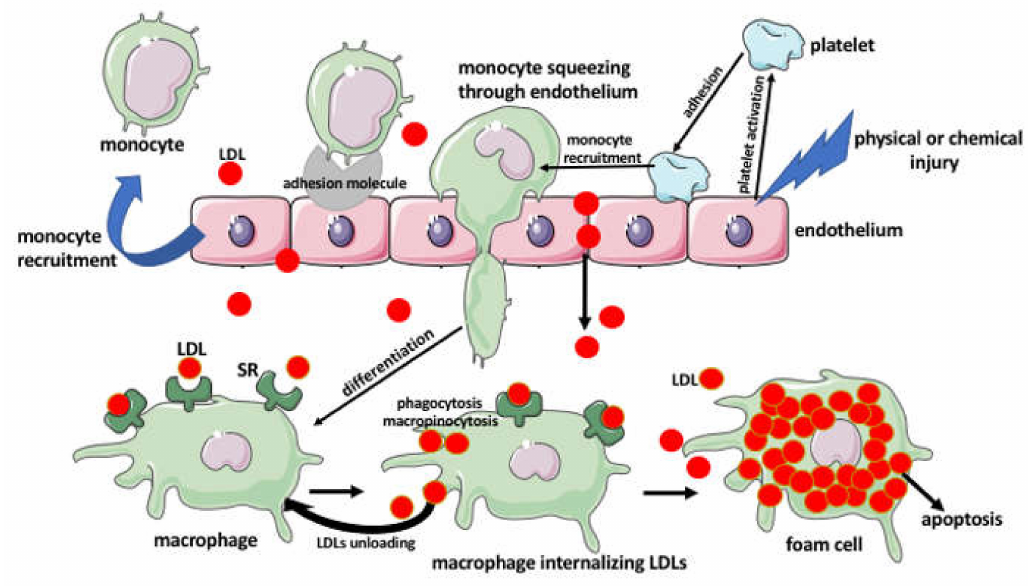
Figure 2. Formation of the macrophage-derived foam cells. The injured endothelial cells change shape, loosen the intercellular tight junction, increasing the permeability of the endothelial barrier, and produce cytokines, which recruit the immune cells. They also produce adhesion molecules such as vascular cell adhesion molecule 1 (VCAM-1), which allows monocytes to adhere and enter the intima. While in the intima, monocytes differentiate into macrophages. Low-density lipoproteins (LDLs) enter the intima from the circulation and become internalized by the macrophages through the binding to the scavenger receptors (SRs) by phagocytosis and macropinocytosis. The macrophage will try to unload the lipids, and if there is a lipid overload the lipid-laden macrophages transform into foam cells that eventually die. Another factor in the recruitment of monocytes to the intima is the platelets. The injured endothelium activates platelets, which adheres to the endothelium and induces further endothelial changes and the monocyte